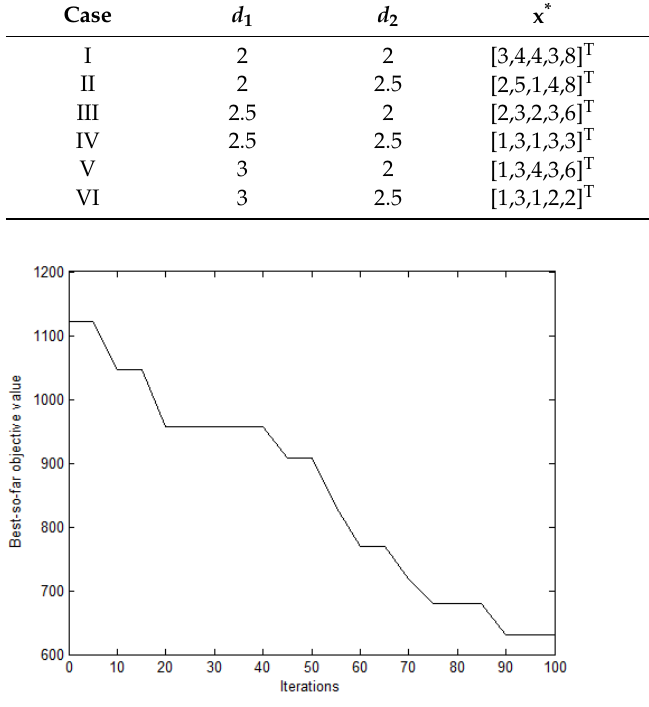
Figure 6. The convergence curve of the best-so-far candidate solution for Case IV.